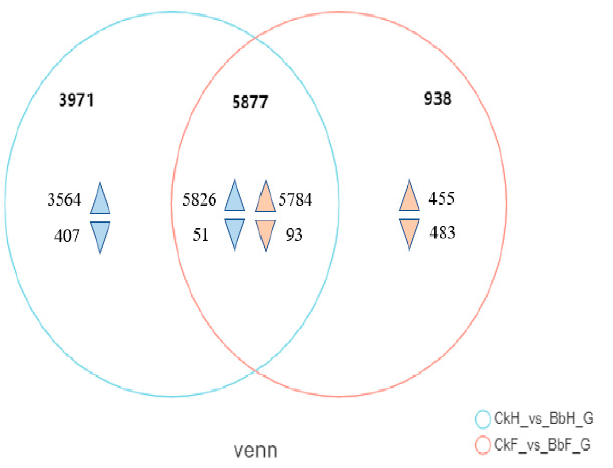
Figure 3. Venn diagram of the statistics of differentially expressed genes (DEGs) between fat body and hemocyte in B. bassiana - and Tween 80-treated E. oblique larvae.